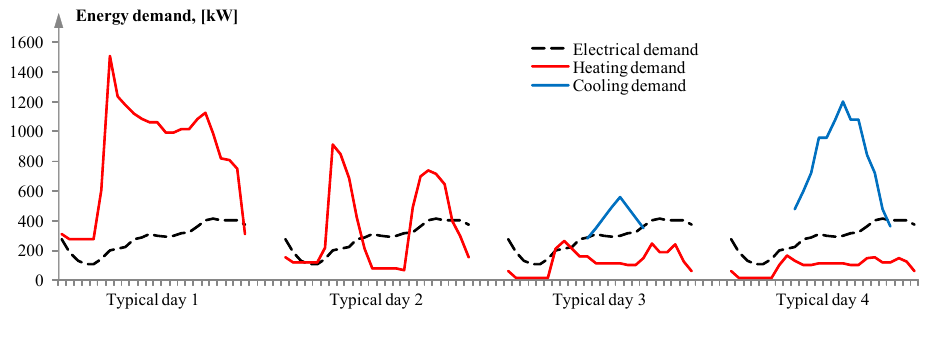
Figure 2. Energy demand for typical